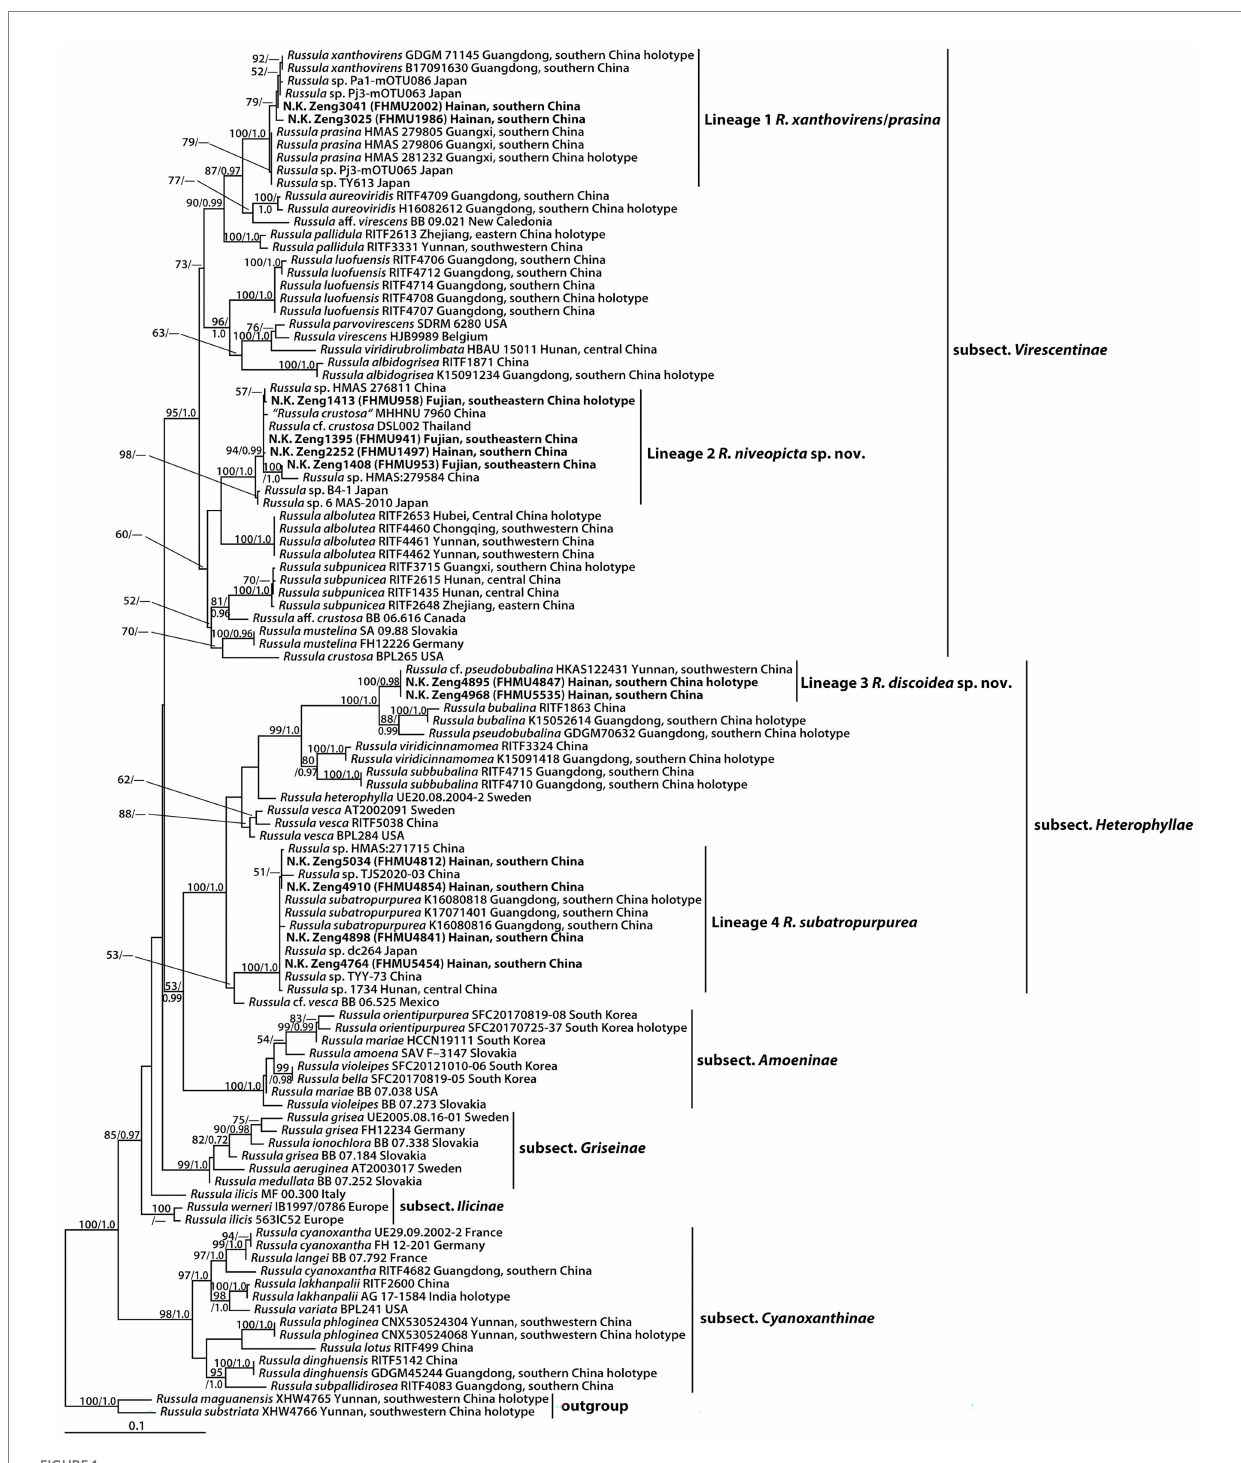
FIGURE 1 Phylogram of Russula subg. Heterophyllidiae inferred from a two-locus (rDNA 28S and ITS) dataset using RAxML. BS ≥ 50% and PP ≥ 0.95 are indicated above or below the branches as RAxML BS/PP.